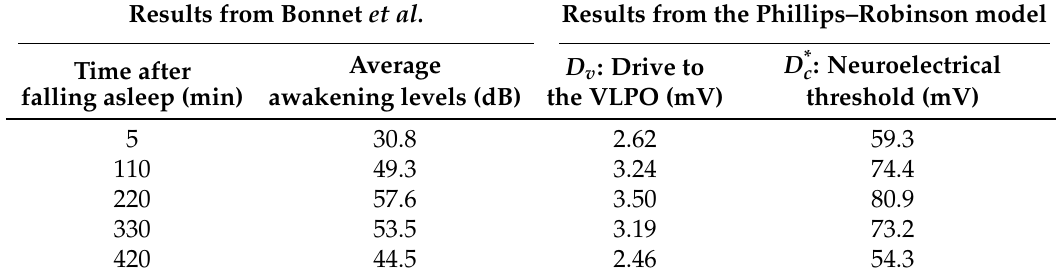
Table 1. Average awakening levels in Bonnet et al. [38] and neuroelectrical thresholds calculated from the Phillips–Robinson model. Values represent the average results from the six study subjects. Results from Bonnet et